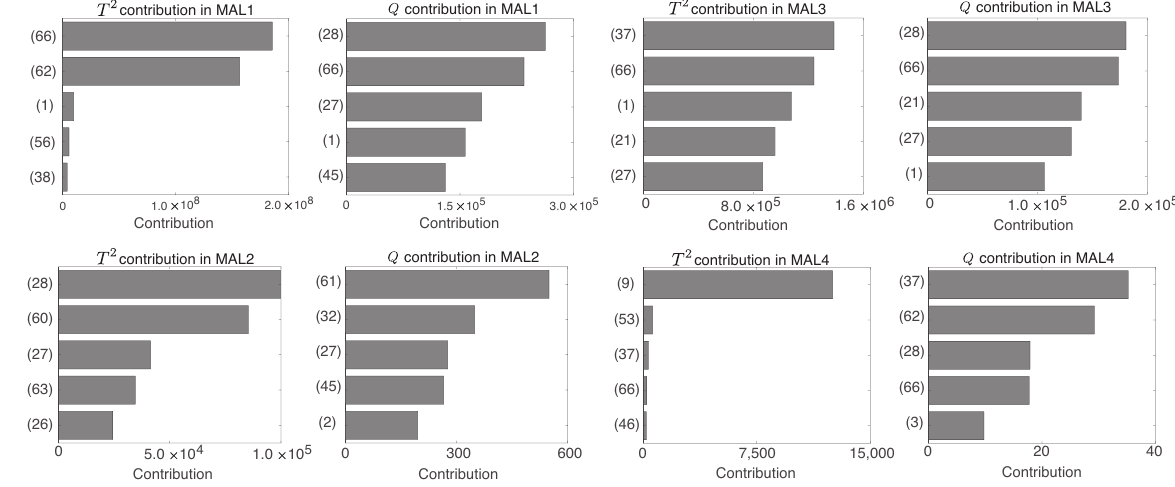
Figure 4. Fault diagnosis results in VAM process by contribution plots. The cause of MAL4 is the pressure change of the O 2 feed. This change affects the operation of streams 4 and 5, the heater, and the vaporizer. The contribution plot of the Q statistic estimated variables (37), (62), and (28) as causes of the fault. The contribution plot of the T 2 statistic indicated variable (9), which did not have causality with respect to the fault. On the other hand, in the proposed method, variables (1), (21), (42), and (54), which are variables of the vaporizer and the heater, were estimated as causes of the fault. Although the contribution plots did not correctly diagnose the cause of MAL4, the proposed causal plot suggested reasonable causes of the fault. The results of fault diagnosis in the VAM process are summarized in Table 3. In all of MAL1–MAL4, the causal plots were able to appropriately indicate the causes of the faults. On the other hand, the contribution plots failed to correctly identify the causes of MAL2 and MAL4. Thus, the proposed causal plots are more suitable for diagnosing process faults than the conventional contribution